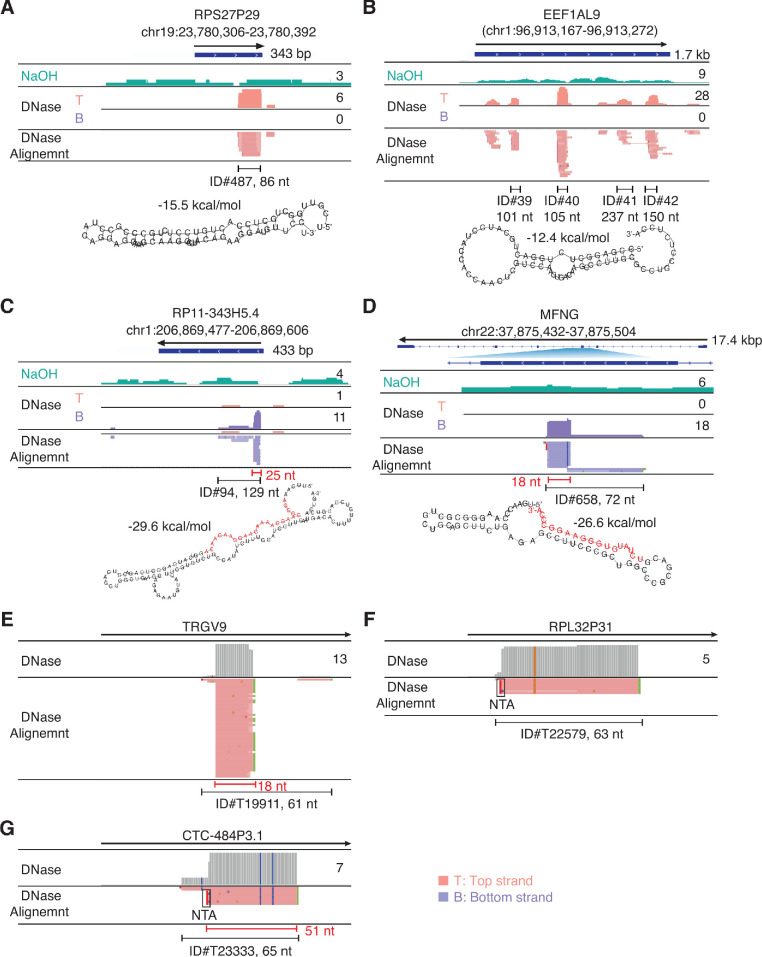
IGV screenshots showing example of peaks mapping to exons or pseudogenes that are comprised of or contain RNA fragments with discrete 5'- and 3'-ends (defined as > 50% of the deduplicated reads having identical 5' and 3' ends).Gene names are indicated at the top with the hg19 coordinates of the called peak indicated in parentheses and the arrow below indicating the 5’ to 3’ orientation of the encoded RNA. IGV coverage plots and alignments are labeled as in Figure 7 with the peak called by MACS2 delineated by the bracketed black line with the peak ID number and length indicated below. (A, B) Peaks with discrete 5' and 3' ends that can be folded by RNAfold into secondary structures with ΔG ≤ −12 kcal/mol. In panel B, which shows a pseudogene with multiple called peaks, the predicted secondary structure is that of peak ID#40 (asterisk) for which >50% of the reads have discrete 5' and 3' ends. Other peaks in this category not shown in the Figure were ID#s T19005, T25471, and T38057 (Supplementary file 1). (C, D) Peaks that can be folded by RNAfold into secondary structures with ΔG ≤ −12 kcal/mol that contain segments (red) corresponding to separate shorter RNAs with discrete 5'- and 3'-ends that comprise part of the peak. The most stable predicted secondary structure and its MFE (ΔG) computed by RNAfold are shown below. Other peaks in this category not shown in the Figure were ID#s T3803*, T13916, T20238, T25941, T34313*, and T34462; the peaks marked with asterisks contain discrete short (14–15 nt) RNAs. (E–G) Peaks that cannot be folded by RNAfold into stable secondary structures but are comprised of or contain multiple reads with discrete 5' and 3' ends. NTA/black boxes are non-templated nucleotides added during TGIRT-seq library preparation.